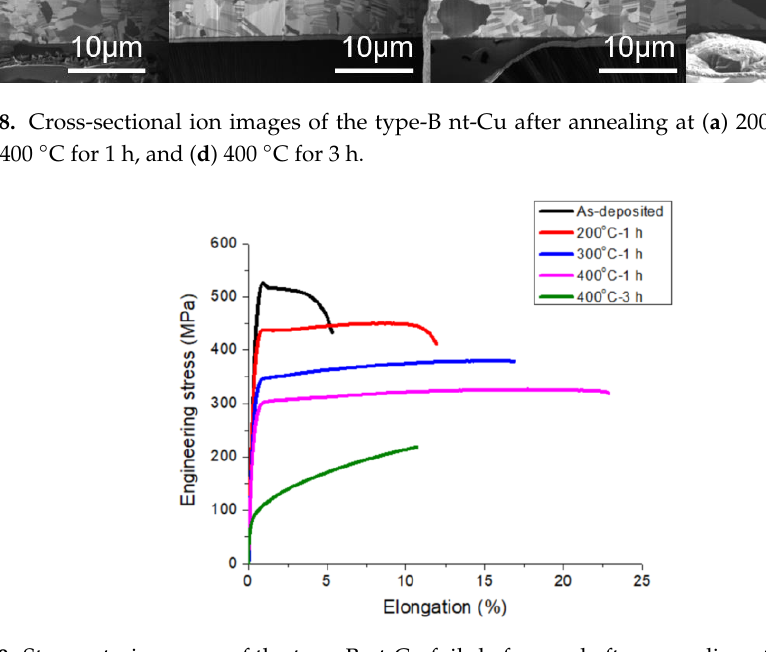
Figure 9. Stress–strain curves of the type-B nt-Cu foils before and after annealing at 200 °C, 300 °C, and 400 °C for 1 h, and 400 °C for 3 h.